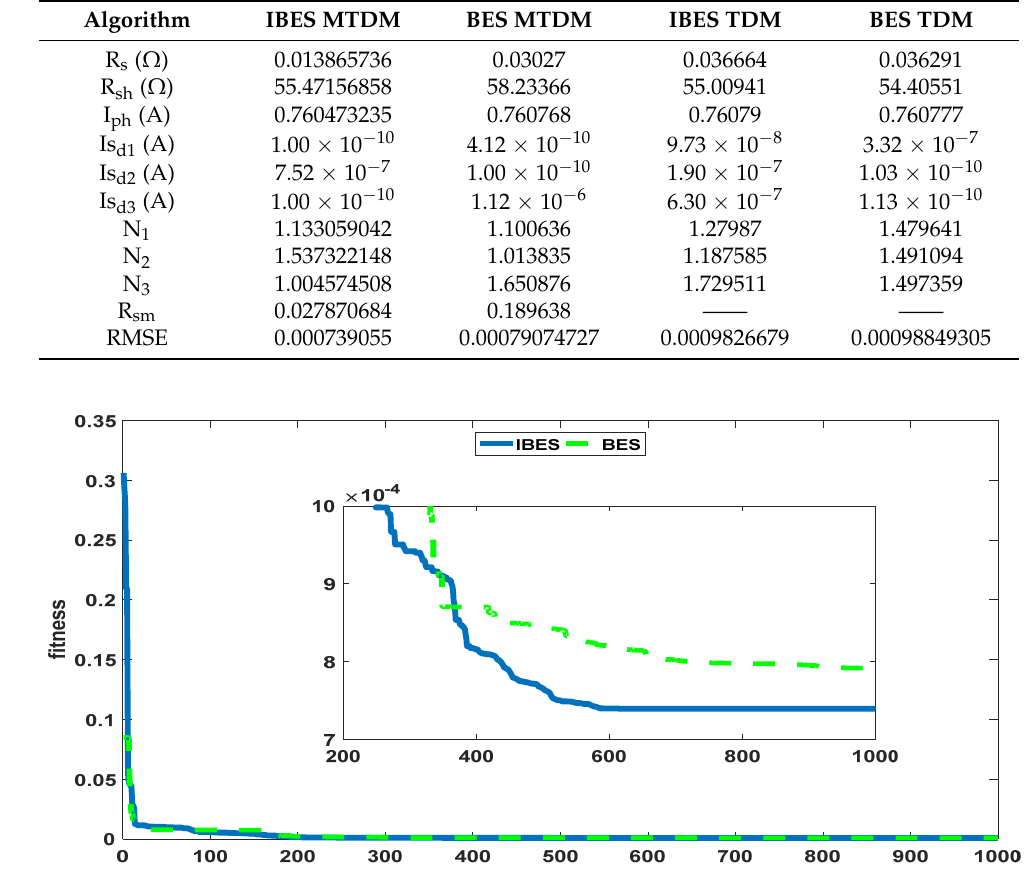
Table 6. Results of the IBES and BES for the MTDM and TDM for a furnace.